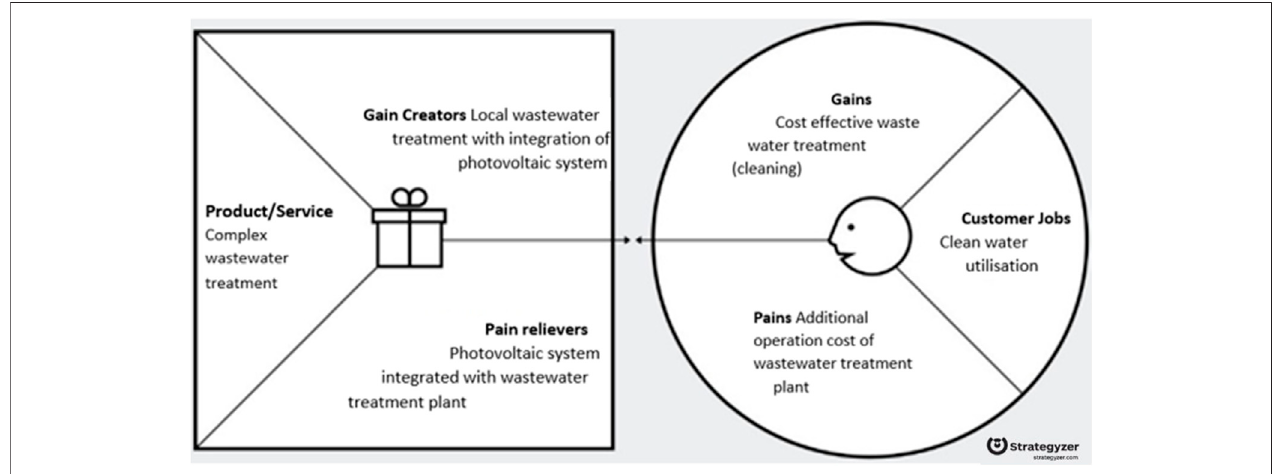
FIGURE 5 | Value proposition canvas (union of municipalities) based on Osterwalder et al. (2014), Strategyzer.com, and with copyright by Strategyzer